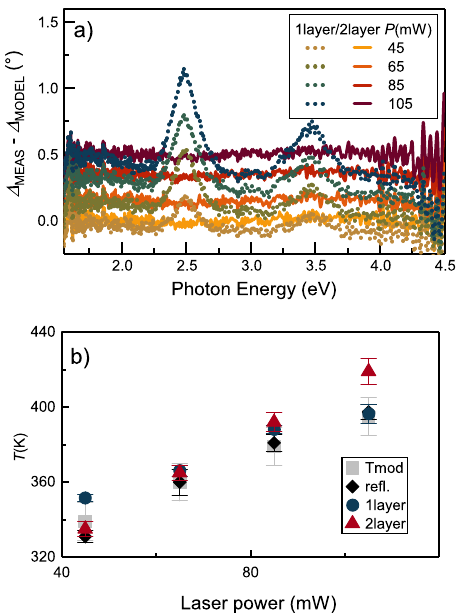
Fig. 3 | Applicability of the different ellipsometric models. a Comparison of the measuredandmodeledellipsometricdata.Dottedcurvesbelongtothesinglelayer model, where the appearing distinct peaks provide a clear indication that this simple model is not able to describe the measured changes suf fi ciently. Solid curves with no modulation belong to the two-layer model, which reproduces per- fectly the measurements. b Temperature of the thin fi lm hosting the SPPs as a function of laser power applied for SPP excitation. Gray squares, black diamonds, dark blue circles and red triangles represent the temperature originating from temperature calculations, from re fl ectivity measurements, from the ellipsometric model considering a single layer with elevated temperature, and from the ellipso- metric model considering two layers, respectively. Error bars of the temperature calculations are de fi ned by the uncertainties of the power converted to SPP exci- tation;forre fl ectivitymeasurements,theuncertaintyof C parameterwastakeninto account; while for the ellipsometric results, error bars originate from thickness uncertainties (standard deviations of the deduced results in all cases).